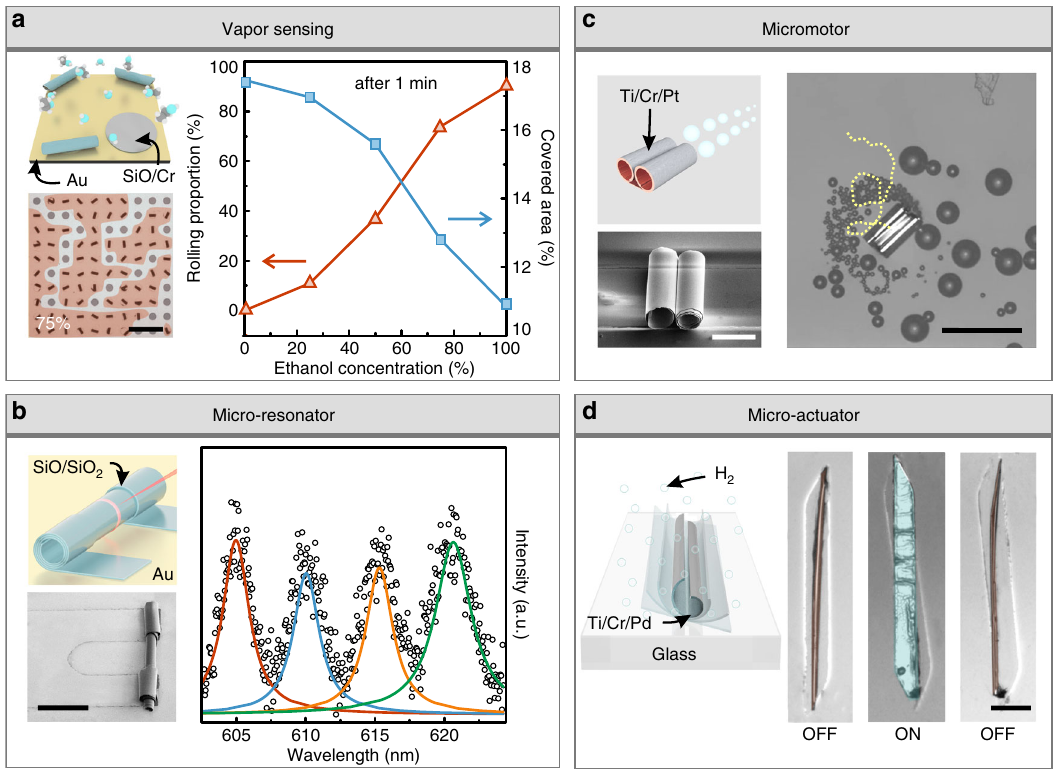
Fig. 5 Extended construction and applications of deterministic rolling microstructures. a Vapor sensing based on spontaneous rolling of patterned nanomembranes. Optical image is an array of 100 nanomembranes under vapor of ethanol – water mixture in 75% concentration for 1 min. Diagram depicts the vapor sensing properties of ethanol concentration recognized by rolling proportion and covered area change. Scale bar, 500 μ m. b Rolled-up microcavities constructed by deterministic rolling of U-shape patterned nanomembrane. Optical image is free-standing microcavity consisting of SiO and SiO 2 . Diagram is the PL spectra of the microcavity. Scale bar, 100 μ m. c Micromotors with two tubes constructed by simultaneously triggered rolling. SEM image is the micromotors consisting of Ti, Cr, and Pt. Optical image depicts the motion of micromotor in 5% hydrogen peroxide solution, in which the yellow line is the trajectory of motion. Scale bar (SEM), 20 μ m. Scale bar (optical), 100 μ m. d Microactuators triggered by hydrogen absorption. Optical images depict the actuation behavior before (left), with, (middle), and without (right) hydrogen stimuli. Scale bar, 100 μ